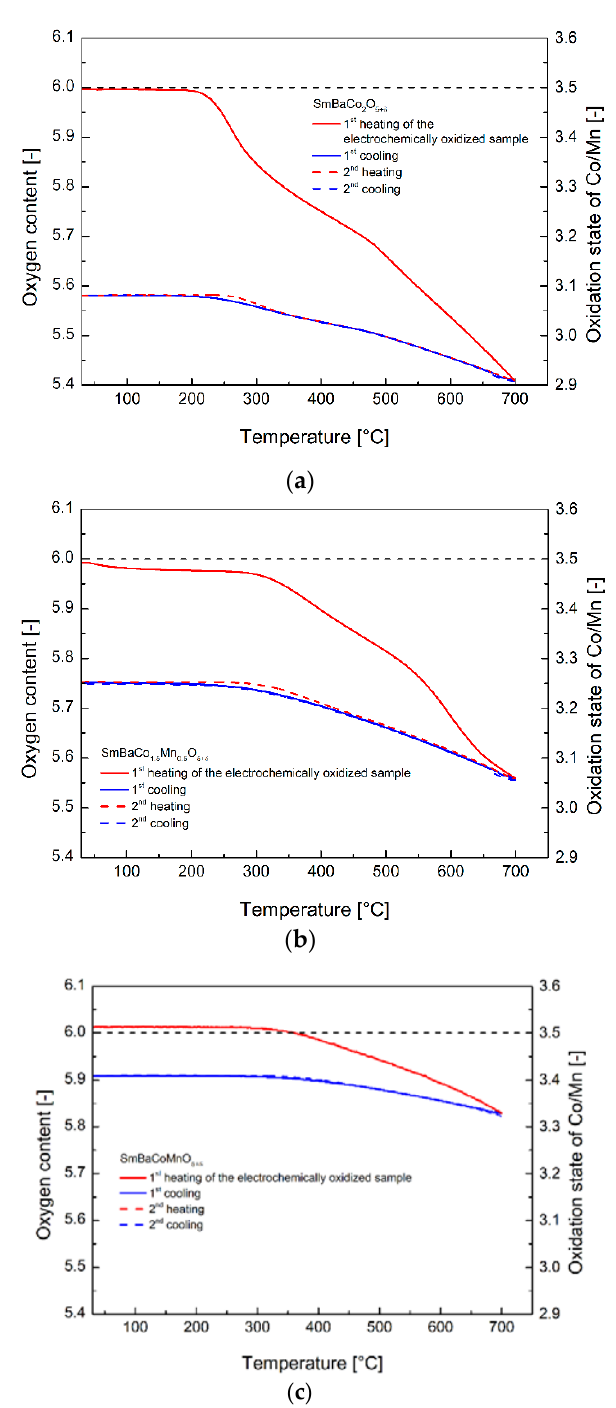
Figure 3. ( a ) Oxygen content as a function of temperature recorded in an air atmosphere for the SmBaCo 2 O 5+ δ oxide. The two cycles presented were preceded by preheating up to 200 °C with the